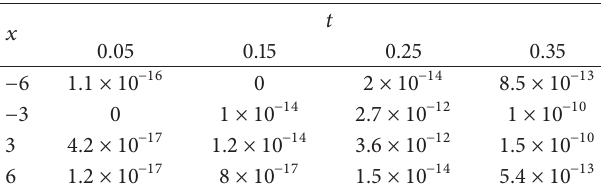
Table 3: Absolute error |𝑢(𝑥,𝑡) − 𝑢 𝑛 = 11 . 𝑥